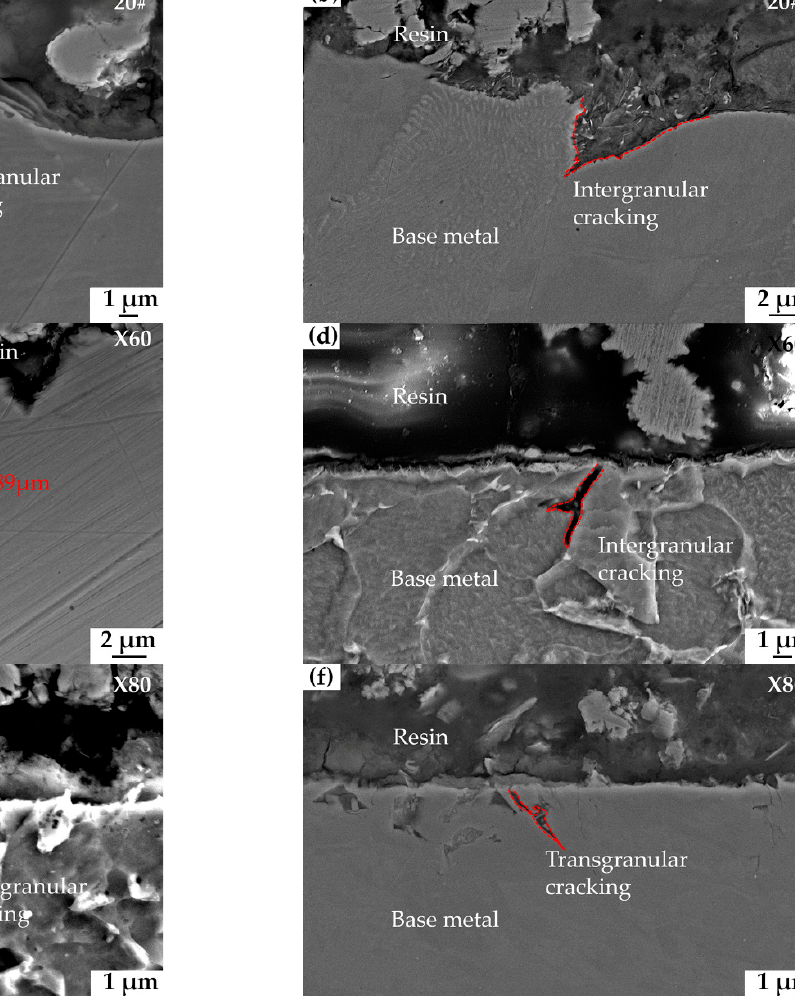
Figure 11. Early crack propagation morphology of different steels after SSRT to the UTS level and immersion for 48 h in a near-neutral pH environment: 20# ( a , b ), X60 ( c , d ), and X80 ( e , f ).